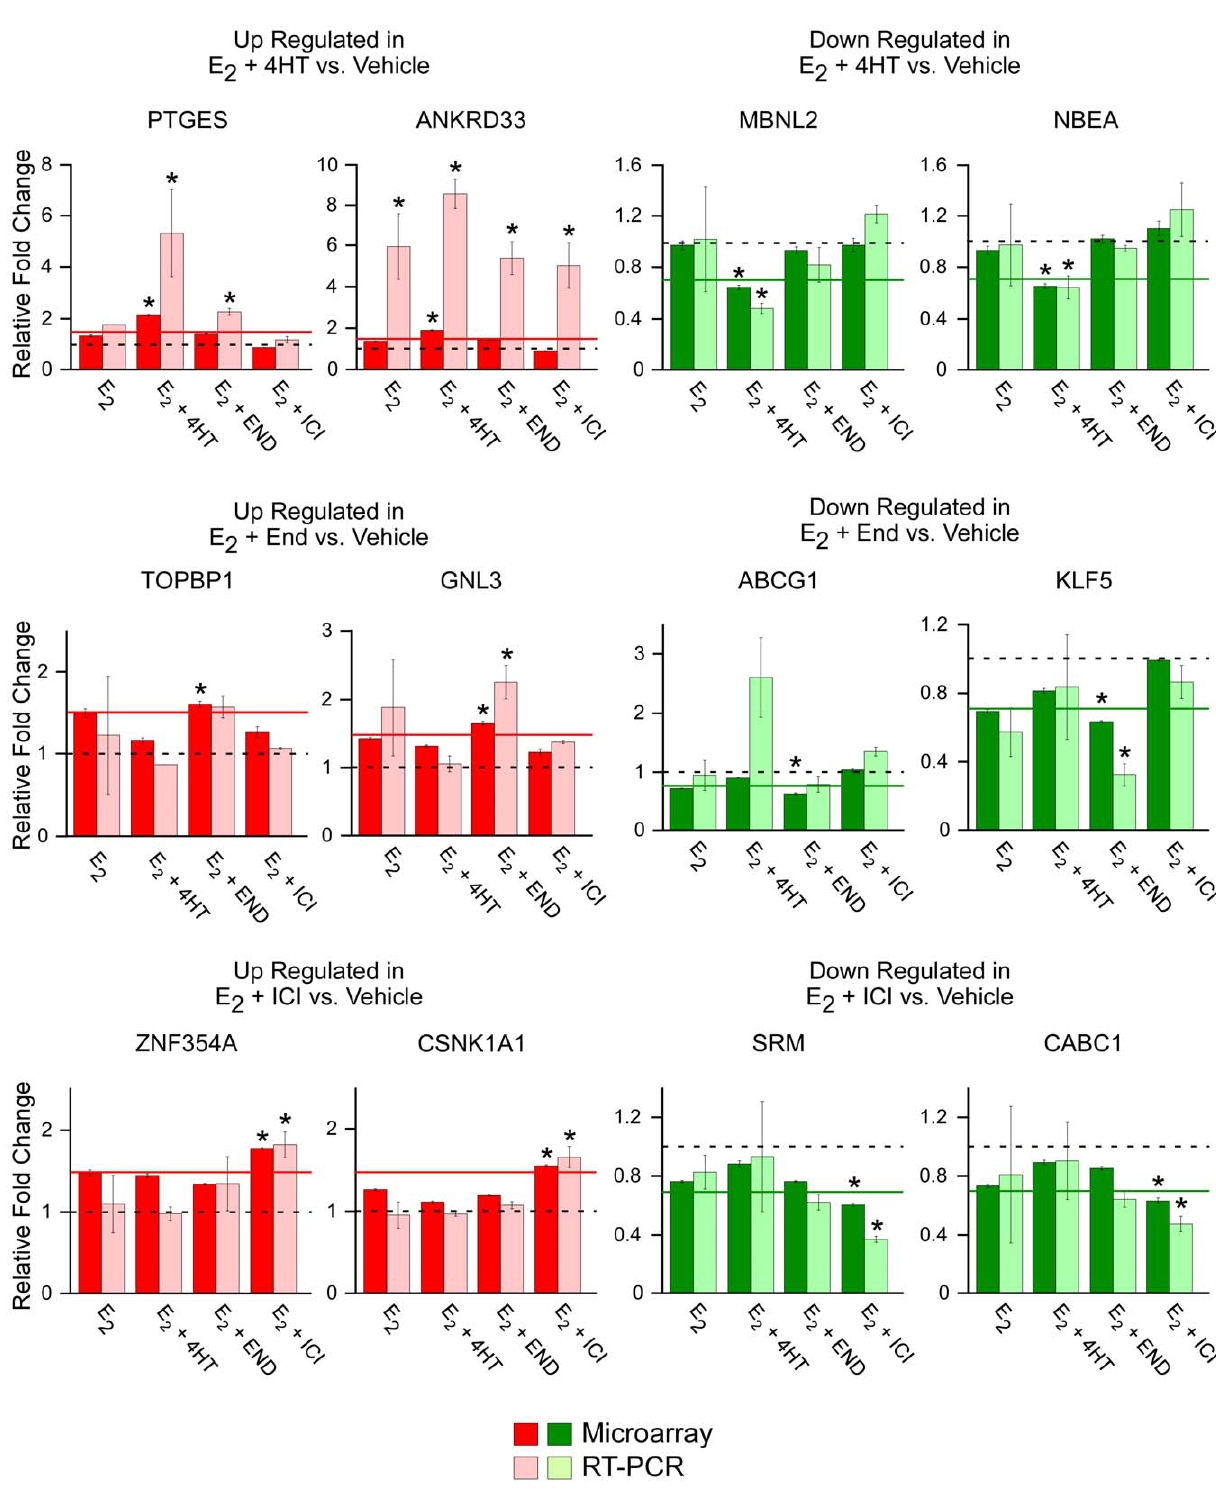
Figure 3. Real-time PCR confirmation of selected genes whose expression levels were either increased (red) or decreased (green) by a specific anti-estrogen. Genes whose expression levels were determined to be specifically increased (red) or decreased (green) by only one of the three anti-estrogen treatments were randomly selected for confirmation of the microarray data. Darkly shaded bars depict relative fold changes from vehicle treated cells (dashed line) as detected by microarray analysis while lightly shaded bars depict fold change as detected by RT-PCR analysis. Solid lines represent the 1.5 fold cut-off used in the microarray analysis. Data represent the mean 6 the standard error of three independent treatments. Asterisks denote values with significant differences at the P , 0.05 level (ANOVA) relative to vehicle treated controls which also met the 1.5 fold cut-off parameter used in the microarray analysis.